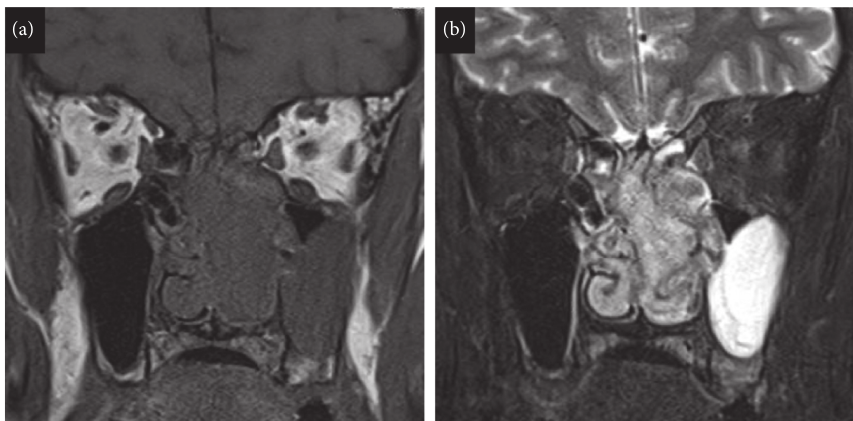
Figure 1: Magnetic resonance imaging. (a) T1-weighted image on coronal section. (b) T2-weighted image on coronal section.